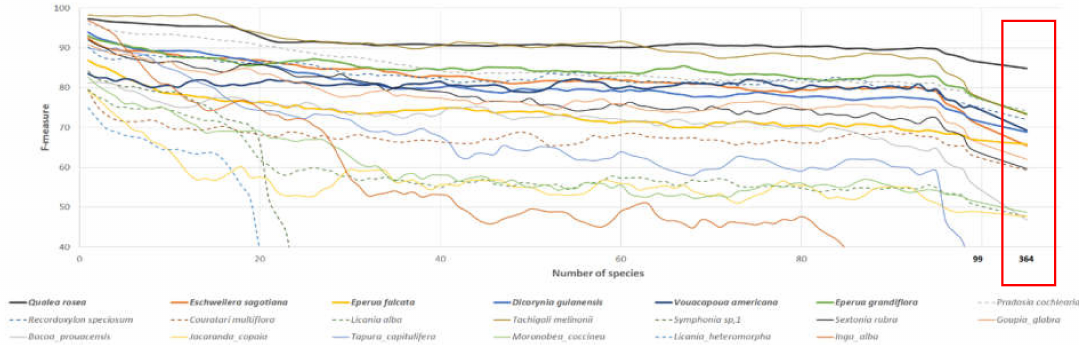
Figure 4. Evolution of species discrimination by successive addition of new species. F-measure value is smoothed using a five-step moving average, except after the 99th species when all remaining species were added at once (red box). Commercially valuable species are plotted in bold